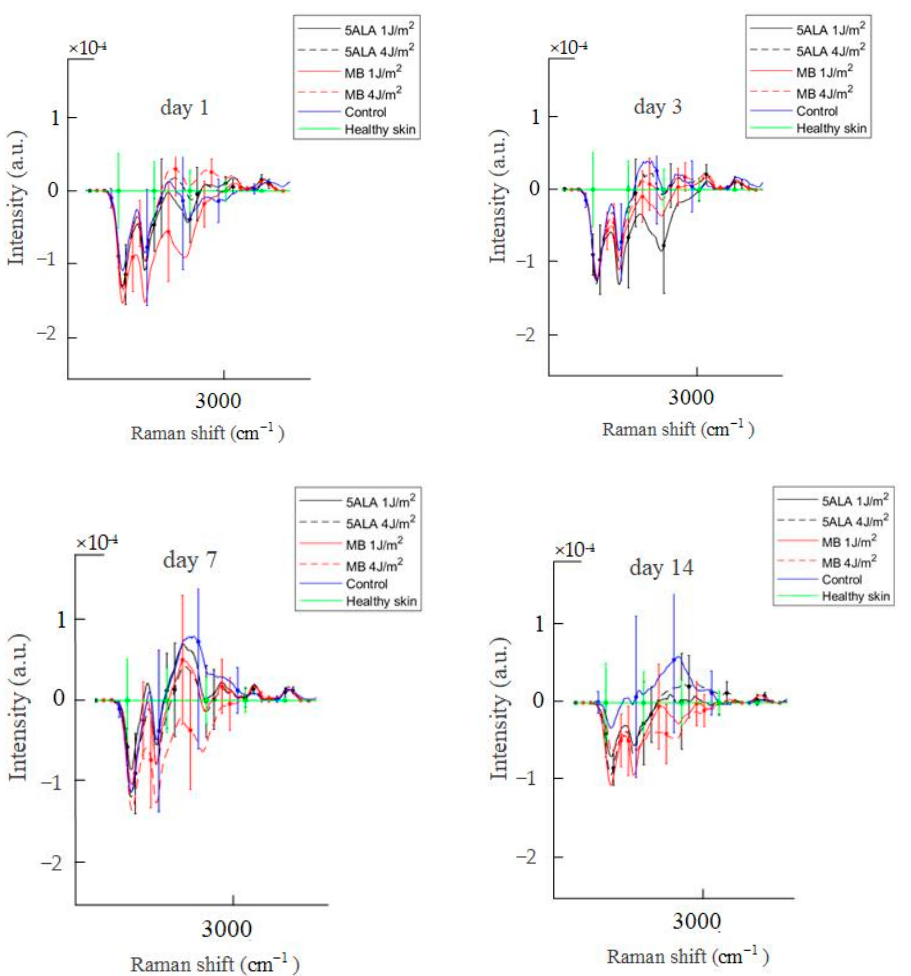
Figure 14. Difference between the wound Raman spectra of all groups subtracting the healthy skin mean Raman spectrum in the 2700–3000 cm − 1 spectral range. The Raman spectra are presented in terms of mean ± StD values. Black line—5ALA 1 J/cm 2 , black dashed line—5ALA 4 J/cm 2 , red line—MB 1 J/cm 2 , red dashed line—MB 4 J/cm 2 , blue line—control, green line—healthy skin (the number of processed Raman spectra was equal to 30 for each group).